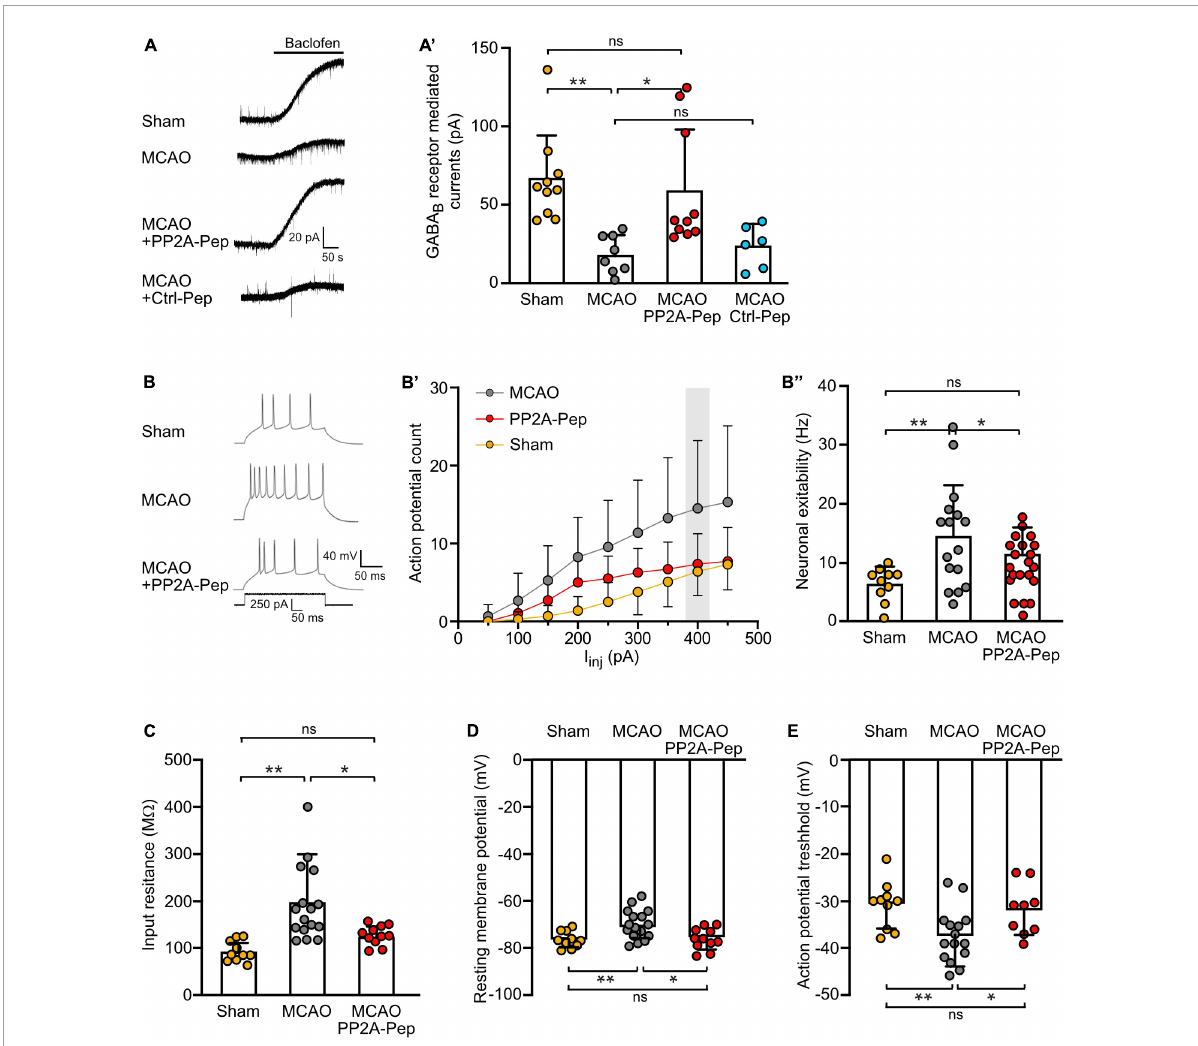
FIGURE8 PP2A-Pep restored GABA B receptor-mediated inhibition and reduced neuronal excitability after MCAO-induced cerebral ischemia. Brain slices containing the somatosensory cortex of sham and MCAO operated mice were analyzed using whole-cell patch-clamp recordings 2–6 h after treatment with PP2A-Pep, Ctrl-Pep or saline. (A) Representative traces of baclofen-evoked currents. (A’) Quantification of baclofen-evoked current traces. The data represent the mean ± SD of 6–10 neurons. One-way ANOVA, Tukey’s multiple comparison test (ns, p > 0.05, * p < 0.05, ** p < 0.01). (B–B”) Neuronal excitability was determined by injecting increasing current steps. (B) Representative current traces. (B’) Quantification of action potential firing evoked by increasing current injections. (B”) Bar graph and statistical evaluation of data depicted in the gray box in (B’) . The data represent the mean ± SD of 10–16 neurons. Brown–Forsythe and Welch ANOVA with Games Howell’s multiple comparison test (ns, p > 0.05, * p < 0.05, ** p < 0.01). (C) Determination of input resistance. (D) Determination of resting membrane potential. (E) Determination of action potential threshold. The data represent the mean ± SD of 10–16 neurons. One-way ANOVA with Tukey’s multiple comparison test (ns, p > 0.05, * p < 0.05, ** p <